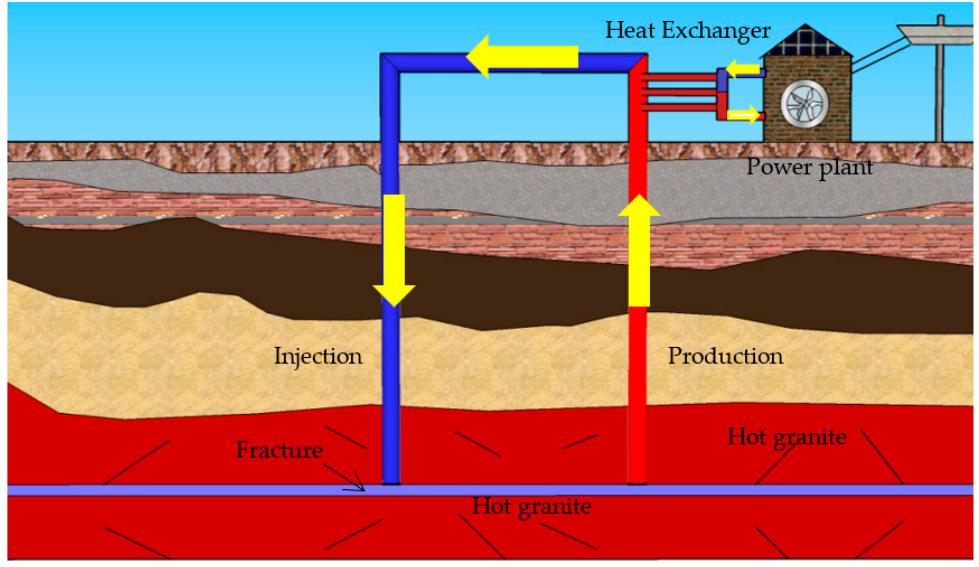
Figure 1. Basic layout of enhanced geothermal system.